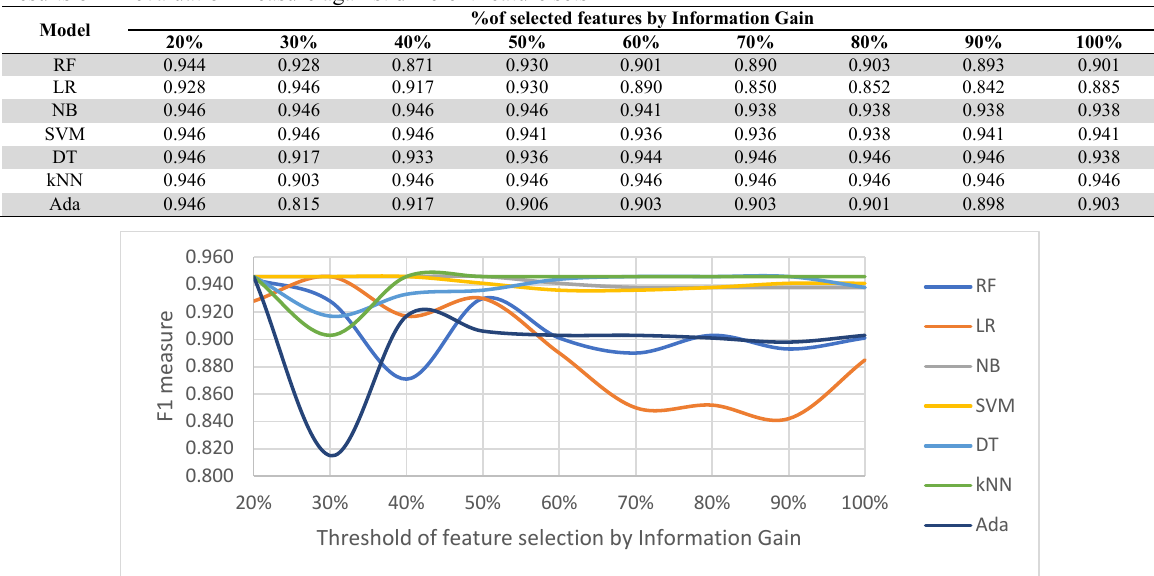
Fig. 7. F1 results for the comparison between different machine learning models using